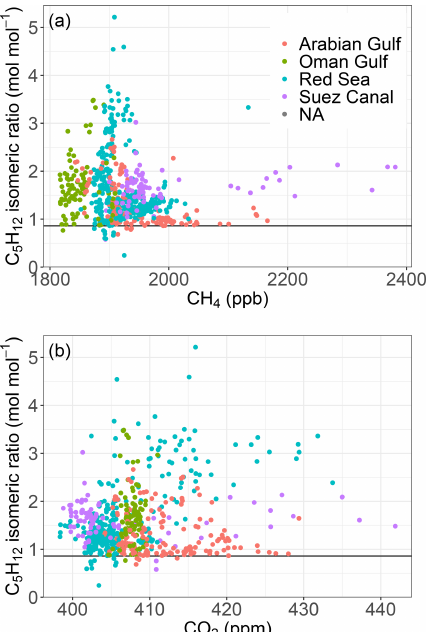
Figure 7. Scatterplot of (a) pentane and (b) propane against methane for the Gulf of Oman, Arabian Gulf, Red Sea and Suez Canal. The regression line and associated uncertainty are plotted for each of these four